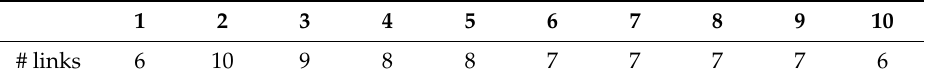
Table A2. Minimum number of communication links per Sinus-Milieus ® category.